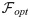
Role of top-down input in the discrimination and detection of stimuli with distractor.The system was trained with the stimuli of Fig 6A. (A) Intra-bulbar disynaptic inhibition among MCs (W(MM)) became less selective with increasing top-down weight wGC. (B) The disynaptic inhibition of MCs by CCs (W(MC)) was selective for an intermediate range of wGC, but not for small or large values of wGC. (C) Fisher discriminant Fopt for the non-optimal discrimination of two similar stimuli in the presence of a distractor (cf. Fig 6 and upper panel of (D)) as a function of wGC. The correct context enhanced the discrimination only when the connectivities W(MM) and W(MC) were selective. Even with the top-down input blocked by setting wGC = 0 during the probing (but not during the network development) the discriminability of the odors was reduced when wGC was increased during the learning (grey line), reflecting the decrease in selectivity of W(MM). (D) Stimuli used for probing in (C,E). (E) Fisher discriminant Fopt for the non-optimal detection of a weak stimulus in the presence of a distractor. Grey line: wGC = 0 during probing but not during training of the network.